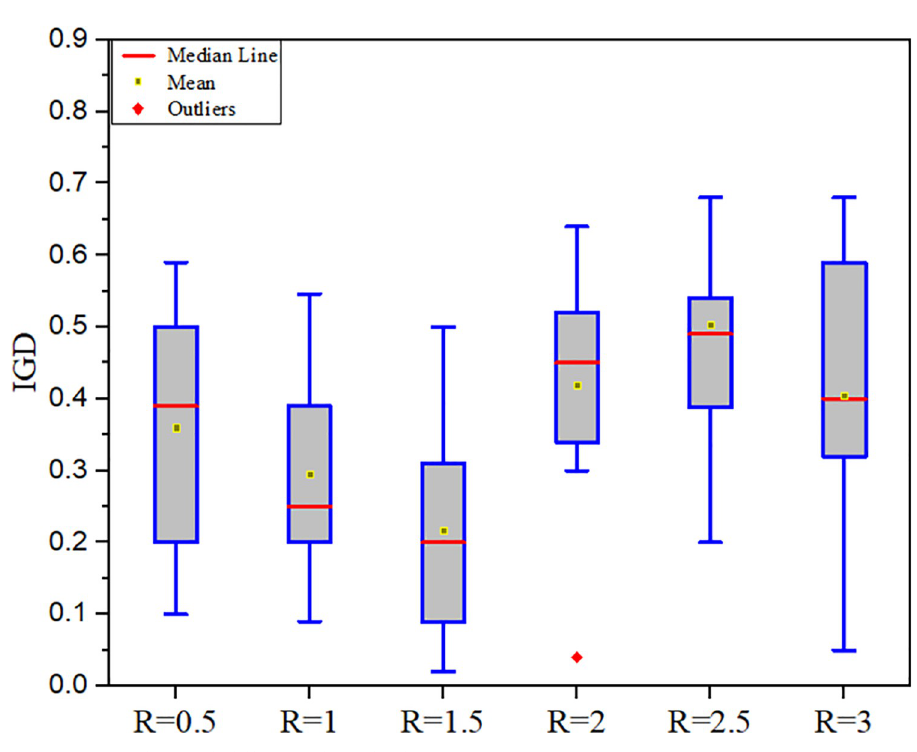
Fig 12. IGD analysis with different values of radius.